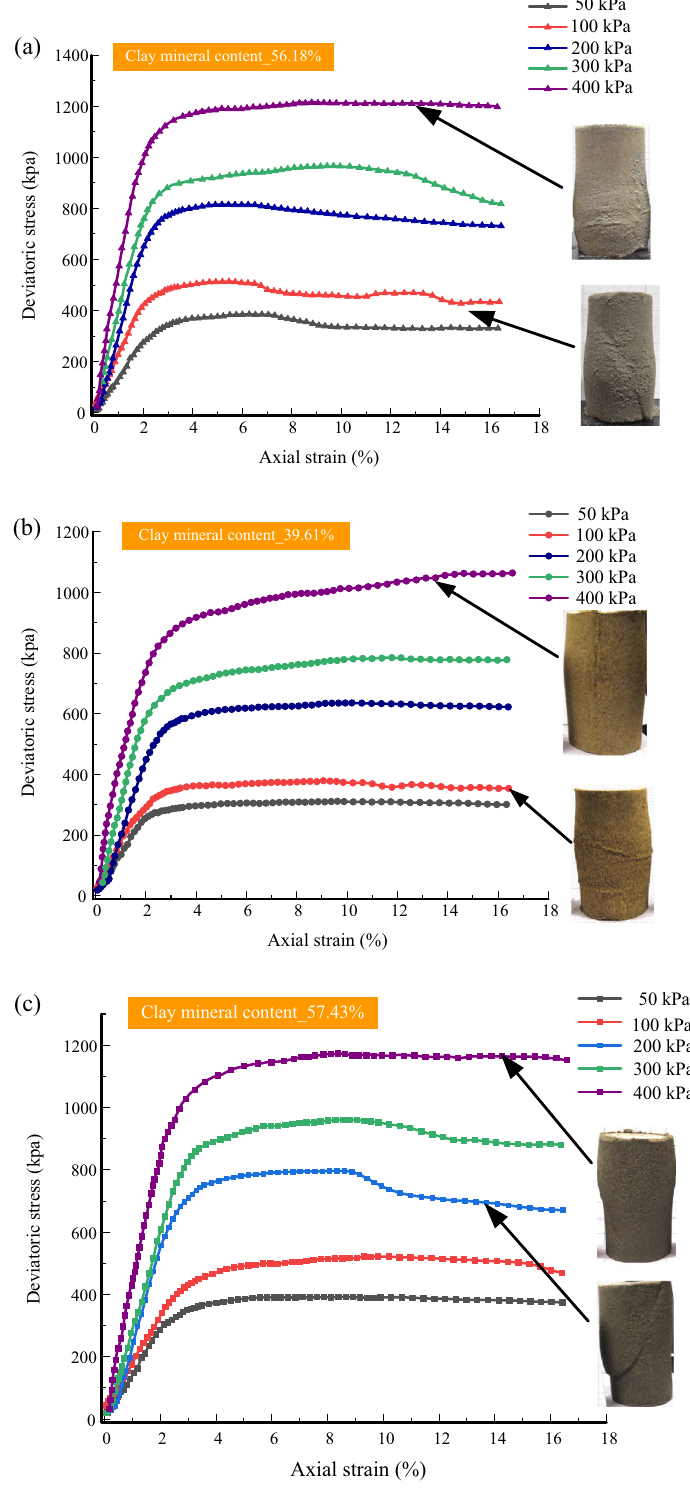
Figure 8. Stress–strain curves of tailings samples: ( a ) CTI, ( b ) CTII, ( c )